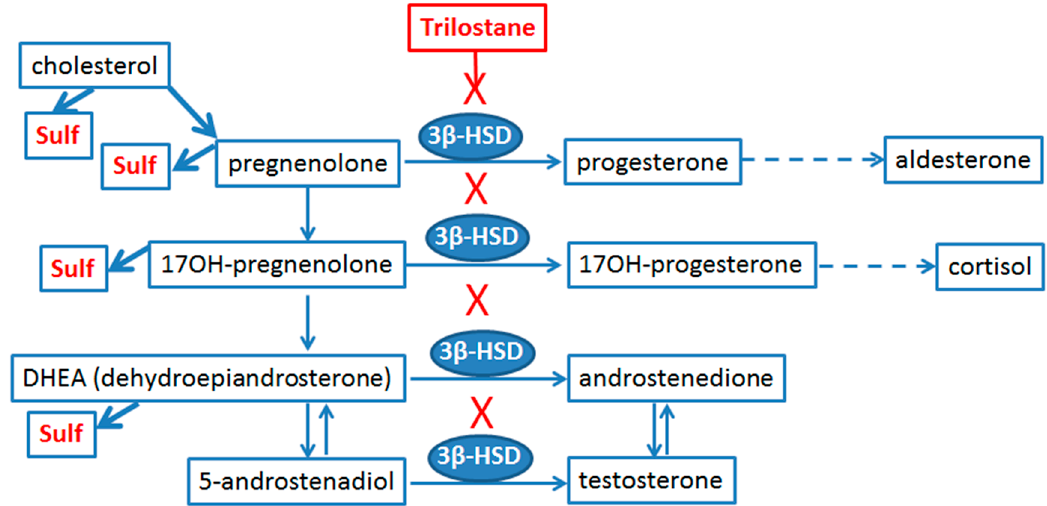
Figure 5. Metabolism of neuroactive steroids in astrocytes and role of trilostane as a competitive inhibitor of 3 β -hydroxysteroid dehydrogenase (3 β -HSD), the key enzyme of steroid transformations. “Sulf” means the sulfate metabolites of substances, “X” means the blocking effect of trilostane, straight arrows connect substrates and metabolites, and dotted arrows indicate participation of several enzymatic transformations (adapted from [49]).